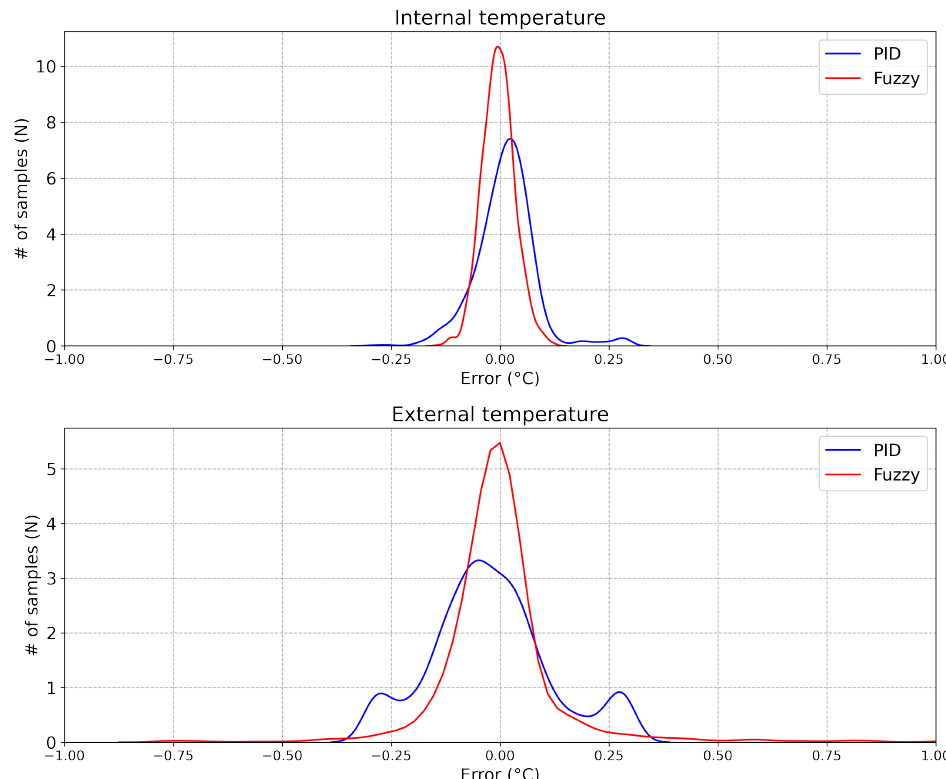
Figure 15. Error distribution of the PID controller (blue line) and Fuzzy controller (red